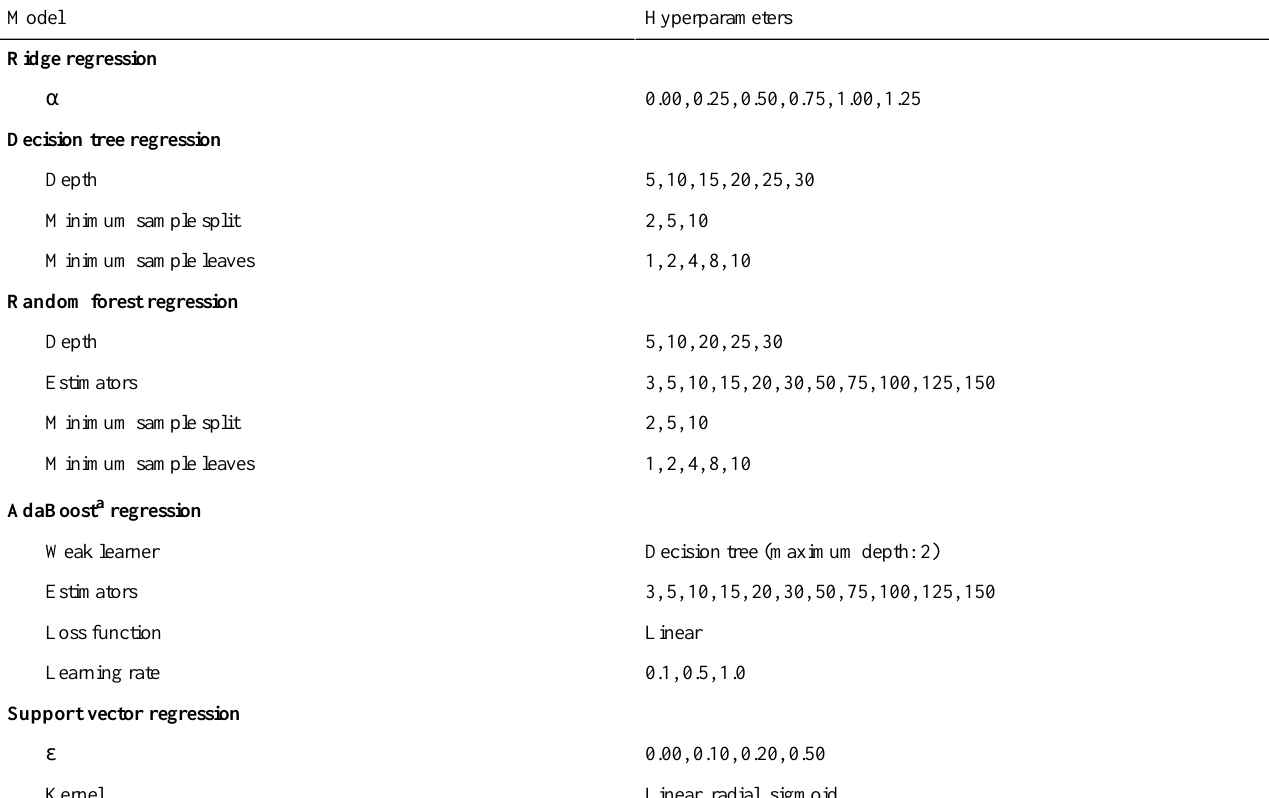
Table 3. Machine learning models and hyperparameter combinations used in the grid